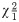
The probability density function (pdf) of the Chi square (χ21) distribution (top panel) and its cumulative density function (cdf, bottom panel).This probability distribution is a typical example of a right skewed inequality distribution. The magenta lines indicate the location of the median (0.47) of the distribution (see also Fig 1 for comparison with less skewed distributions).